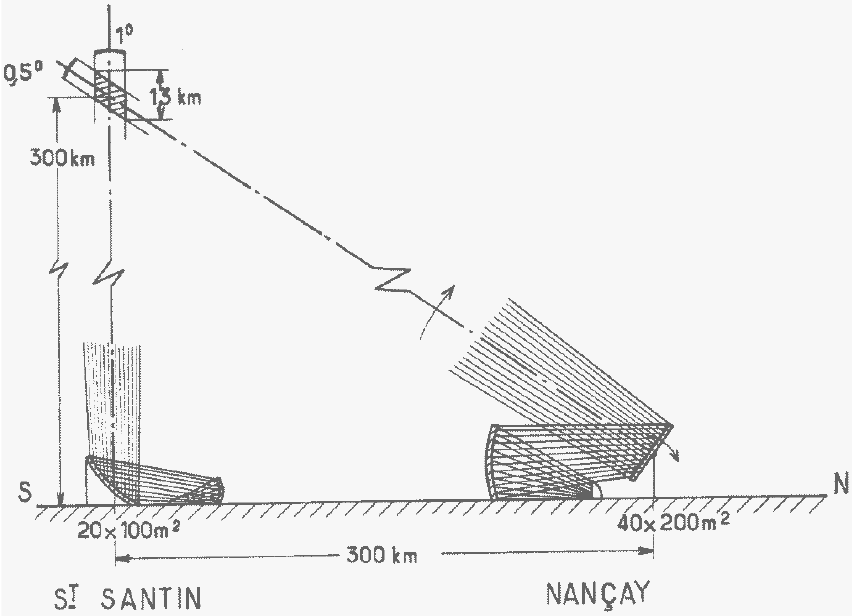
Figure 1. Set up of the Saint Santin incoherent scatter system. The transmitter located in Saint Santin illuminated a vertical column. The Nançay Radio telescope, located 300km north of Saint Santin, scanned the vertical column in order to collect power scattered by the